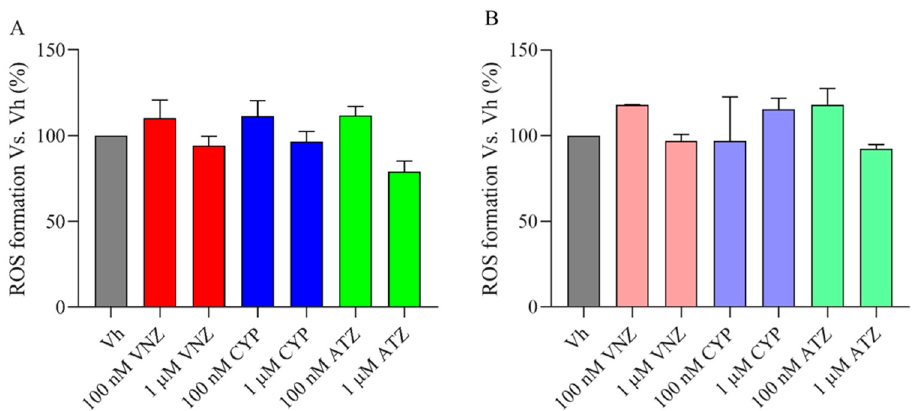
Figure 3. ROS formation in undifferentiated and differentiated SH-SY5Y after the treatment with EDCs. Undifferentiated (A) and differentiated (B) SH-SY5Y cells were treated for 48 h with VNZ, CYP, or ATZ at 100 nM or 1 µ M and ROS formation was determined using the fluorescent probe H2DCF-DA. Data are expressed as fold increases in the percentage of ROS formation versus the vehicle group and reported as mean ± SD of three independent experiments (One-way ANOVA, post hoc test Dunnet).